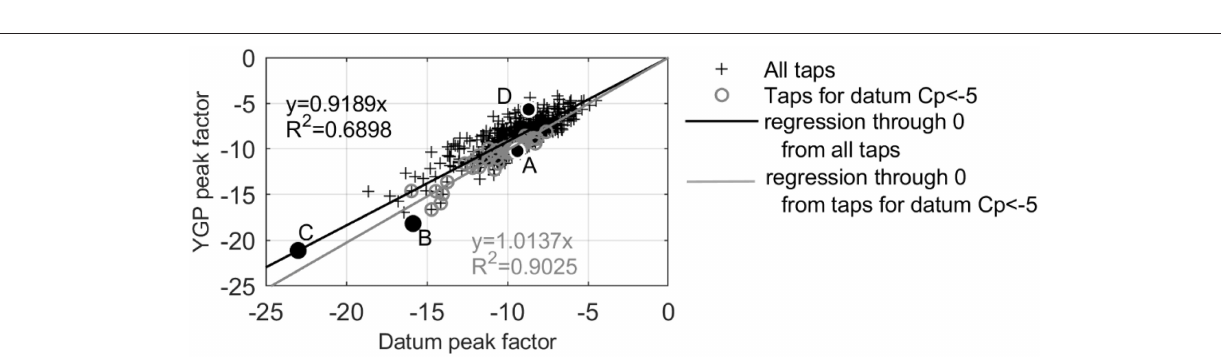
FIGURE 14 | Q-Q plot of YGP peak factor vs. the equivalent datum peak